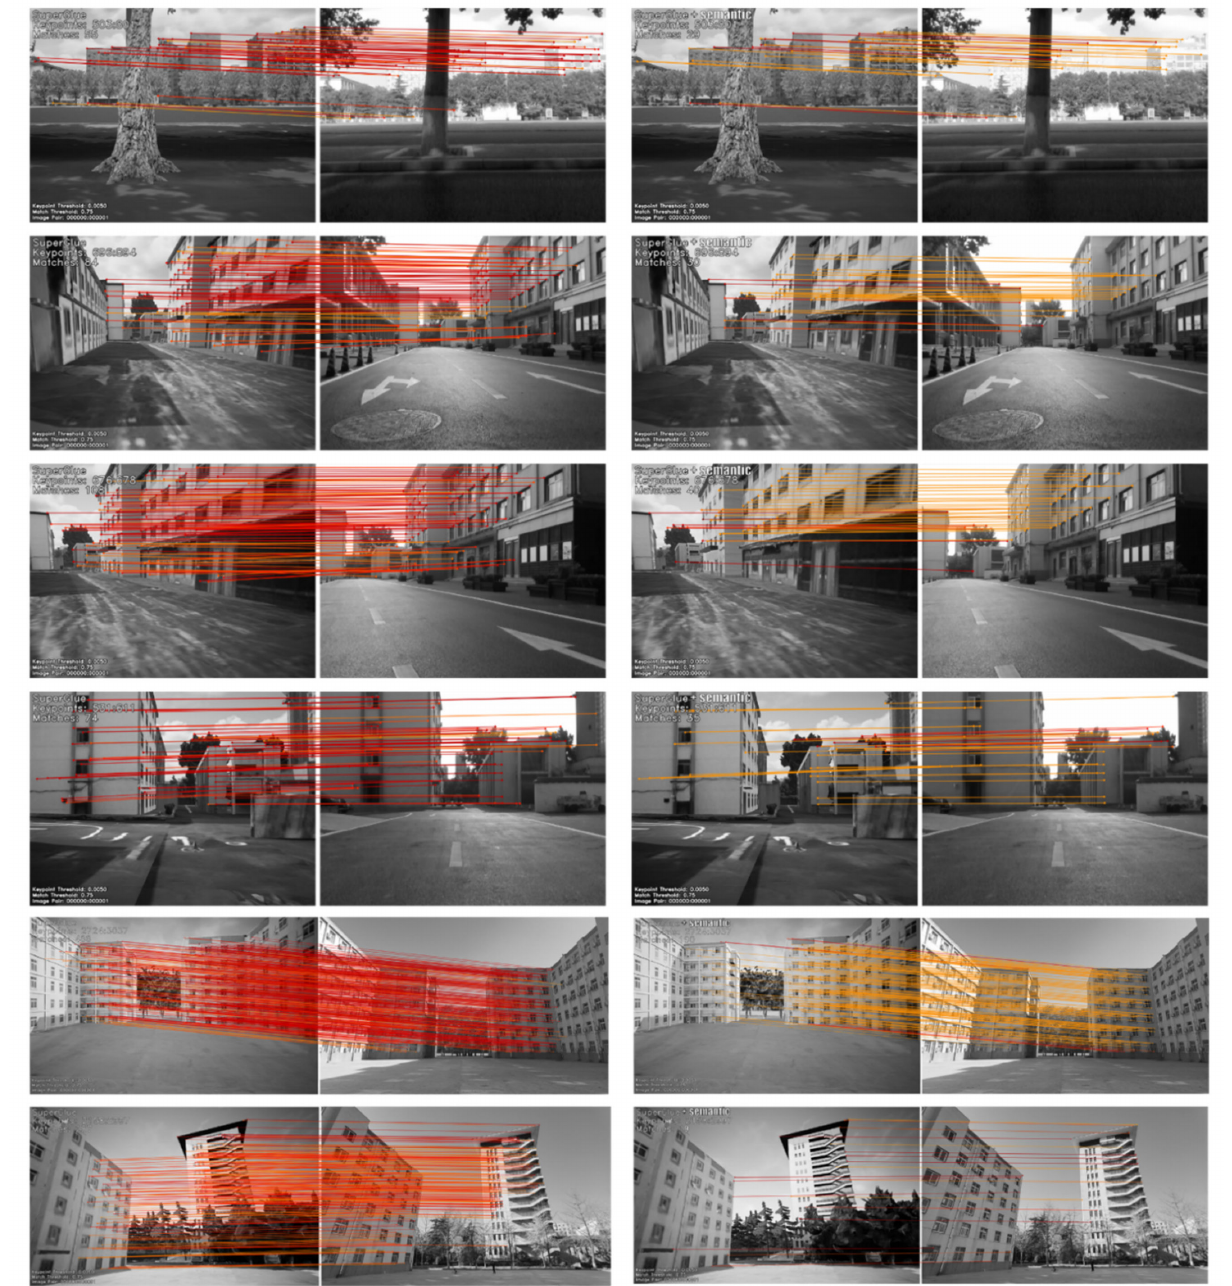
Figure 6. Matching results obtained before and after the semantic optimization. (The yellow to red lines show confidence rates from low to